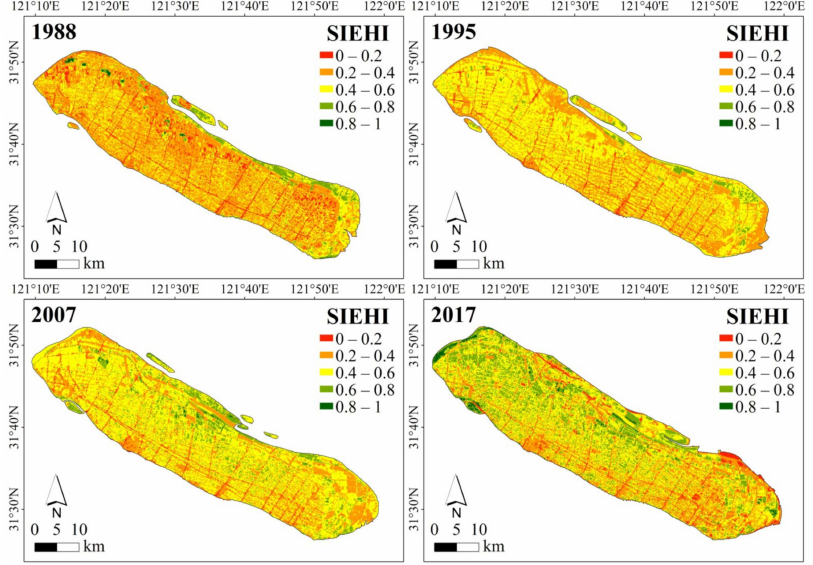
Figure 10. Maps of SIEHI in the four years: SIEHI: sandy island ecosystem health